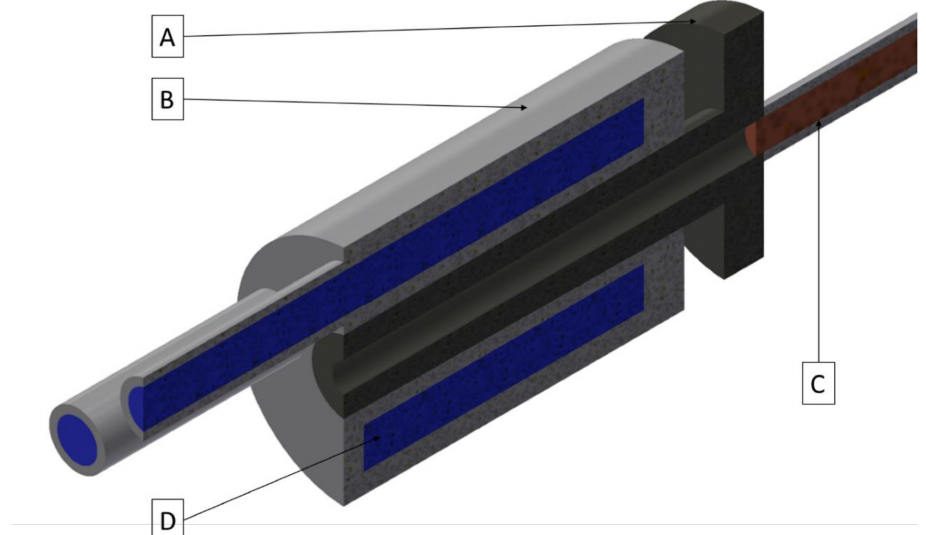
Figure 2. A cross-section of the crystallization system; ( A )–a graphite crystallizer, ( B )–a copper cooling system, ( C )–a copper cast rod, ( D )–cooling